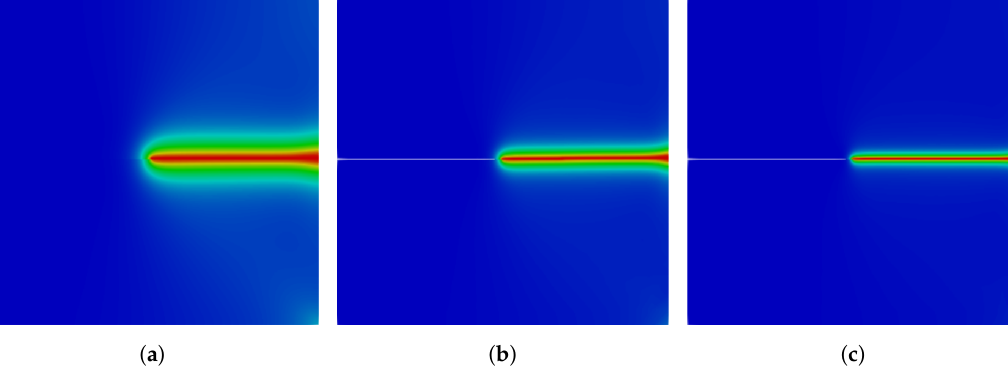
Figure 13. Tension test phase field evolution for ( a ) u = 0.0057 mm ( b ) u = 0.00585 mm ( c ) u = 0.00595 mm, with displacement increment ∆ u = 1